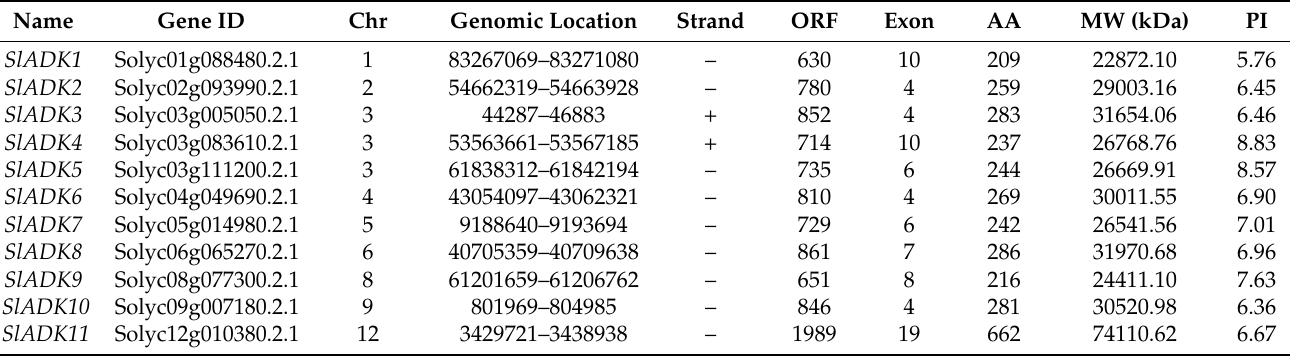
Table 1. Features of SlADK family genes identified in tomato.